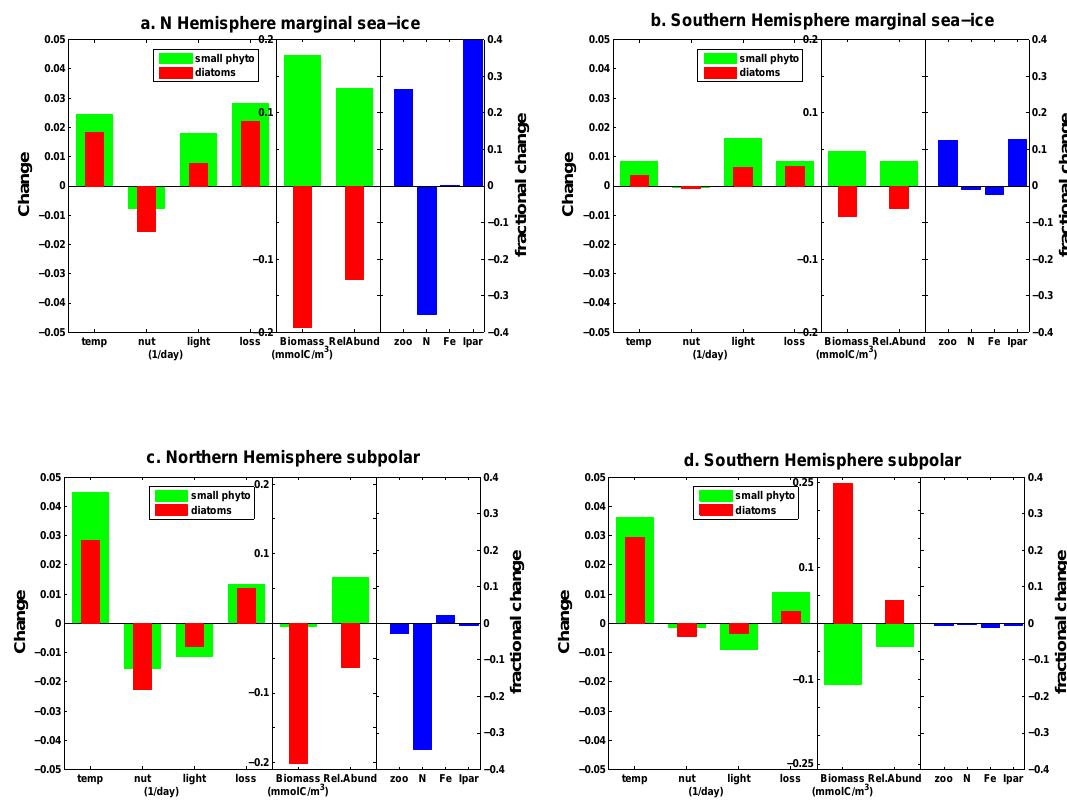
Fig. 8. Same variables as in Fig. 7 averaged for (a) the Northern Hemisphere marginal sea ice biome (b) the Southern Ocean marginal sea ice biome (c) the Northern Hemisphere subpolar biome (d) the Southern Ocean subpolar biome. Light and temperature impacts on growth are most important in the marginal sea ice biomes and subpolar biomes,